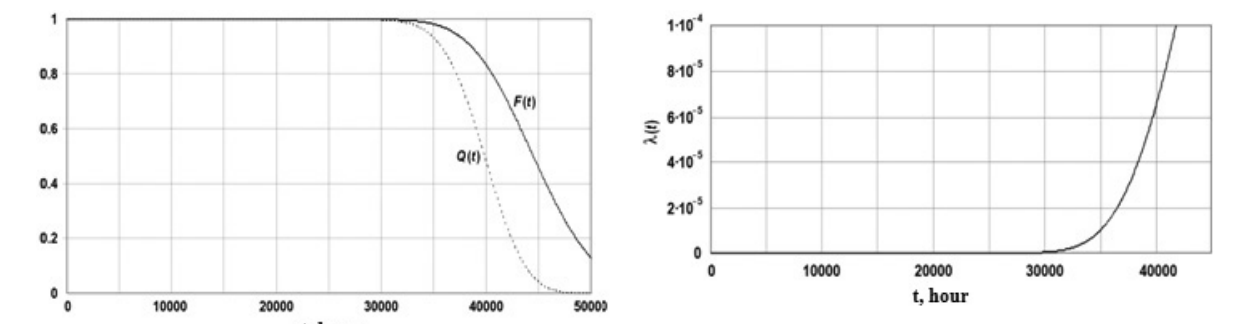
Figure 3. Failure rate diagram of the coolant flow measurement system quadrant.